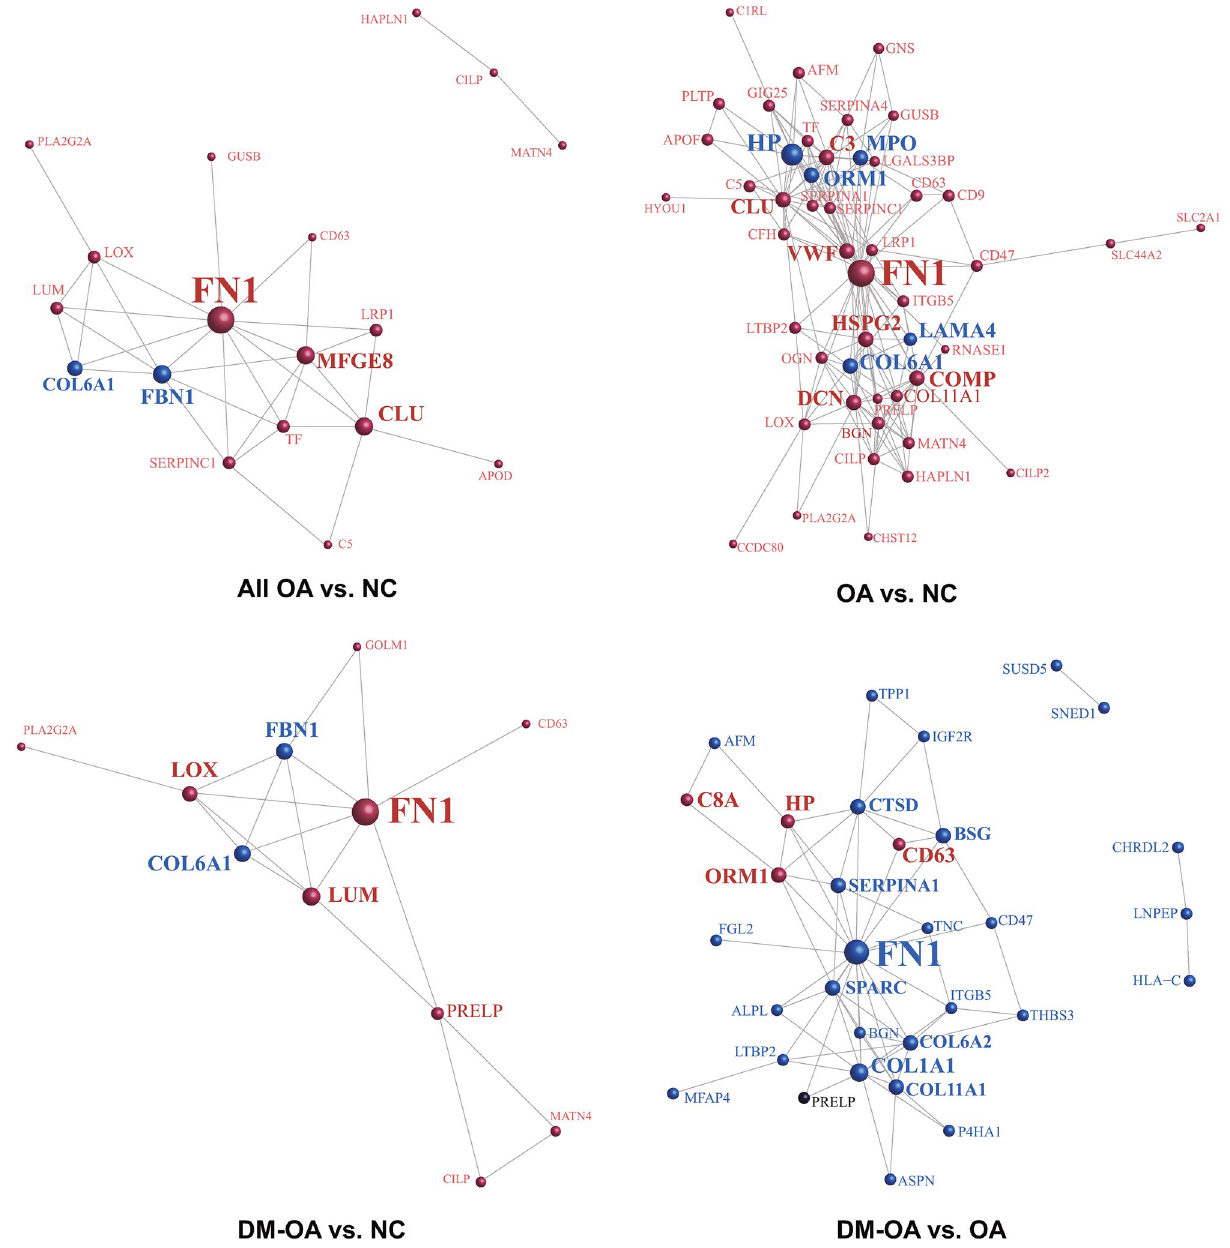
Figure 4. Protein–protein interaction (PPI) analysis of N-glycoprotein. The protein interaction network diagram drawn by Cytoscape software (http:// www. cytos cape. org/, version 3.2.1) is based on the N-glycoproteins corresponding to the differentially expressed N-glycosylated peptides fragments. The nodes indicated the differentially expressed N-glycoprotein and the connecting lines indicated the interactions between proteins. Down-regulated proteins are shown in blue while upregulated genes are shown in red. Proteins possessing multiple N-glycopeptides which were oppositely regulated are marked in gray. The size of the circle indicates the number of proteins directly interacting with a